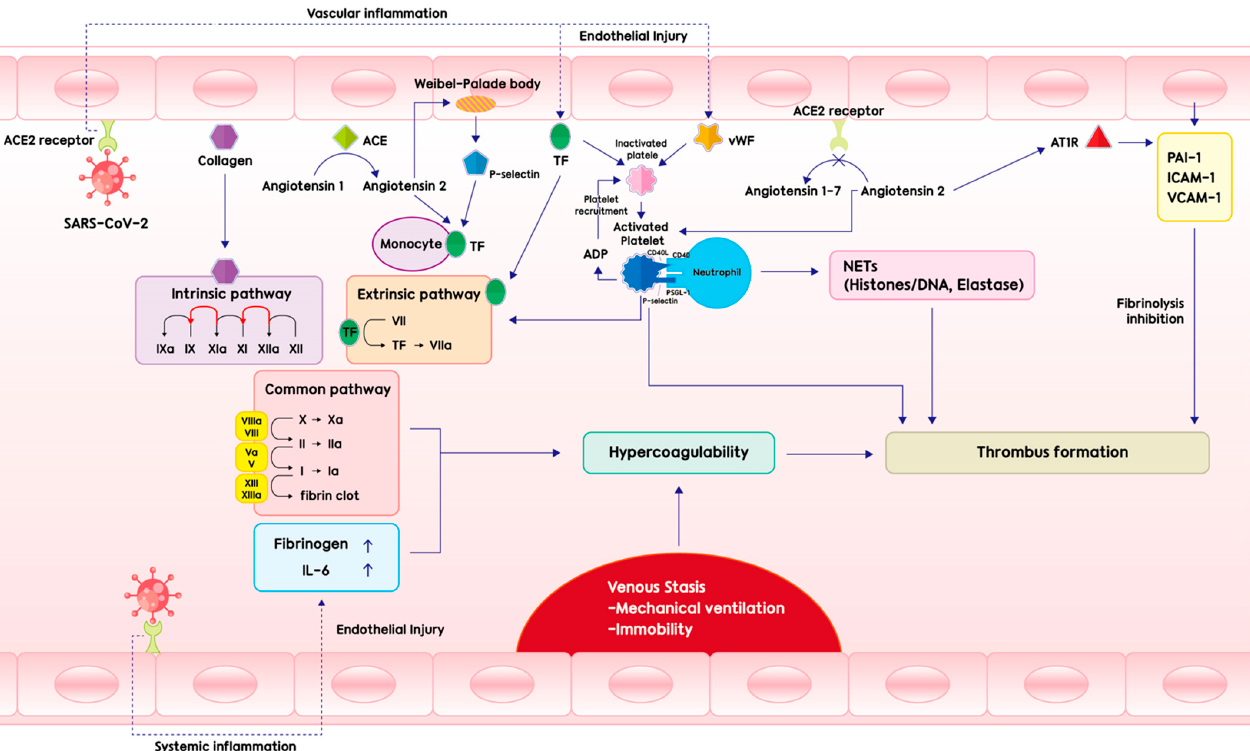
Figure 1. Pathophysiology of thrombosis in patients with COVID-19. Abbreviations: ACE, angiotensin-converting enzyme; TF, tissue factor; vWF, von Willebrand factor; ADP, adenosine diphosphate; ACE2 receptor, angiotensin-converting enzyme 2 receptor; AT1R, angiotensin II type 1 receptor; NETs, neutrophil extracellular traps; PAI-I, plasminogen activator-1; ICAM-1, intercellular adhesion molecule 1; VCAM-1, vascular cell adhesion molecule 1; IL-6, interleukin-6.